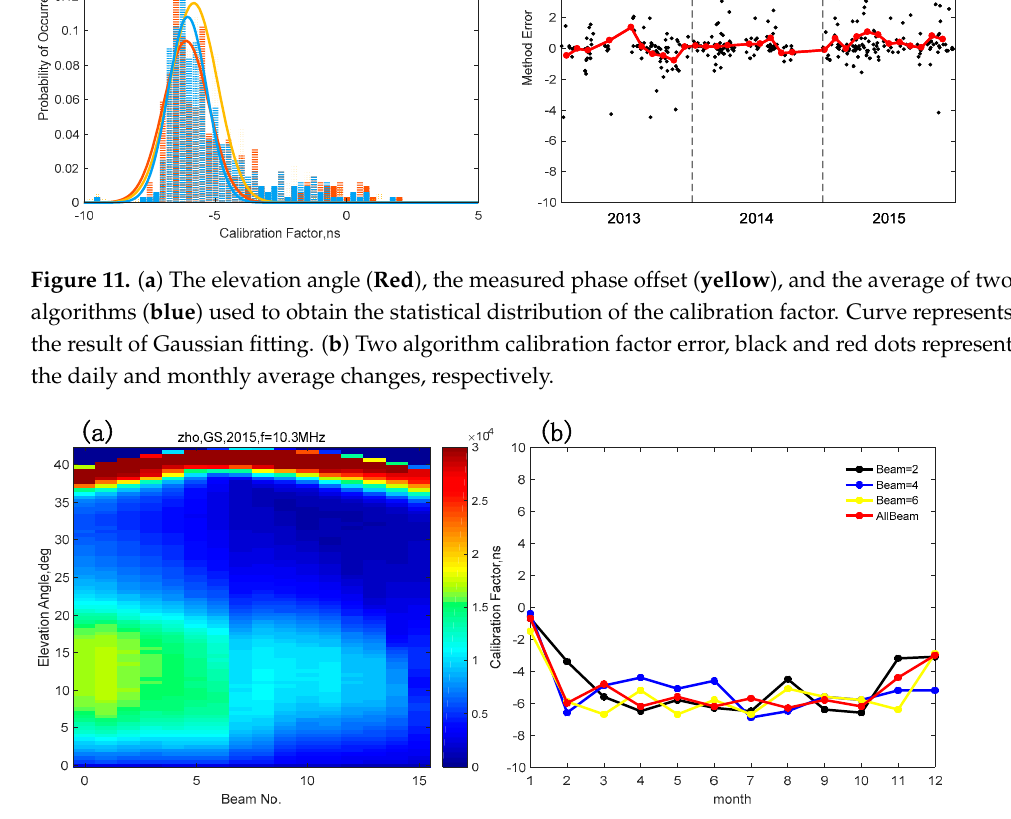
Figure 12. ( a ) The histograms of the beam number and elevation angle distributions observed by the Zhongshan radar. ( b ) Monthly variation of different beam calibration factors in 2015.